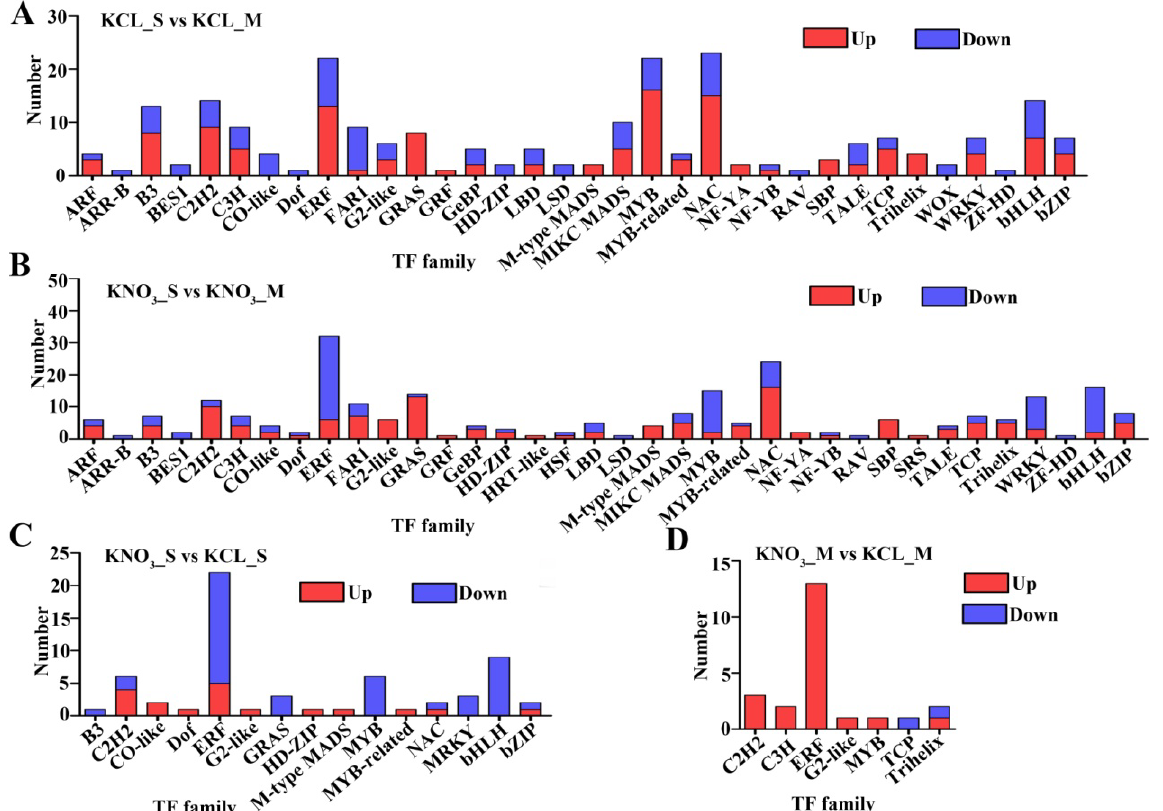
Figure 6. The number of differentially expressed transcription factor (TF) identified in the four comparison groups. ( A , B ) Transcription factor families identified in the comparison between S and M treated by KCL and KNO 3 . ( C , D ) Transcription factor families identified in the comparison between KCL and KNO 3 treatment in S and M. Blue: down-regulated TFs, Red: up-regulated TFs.